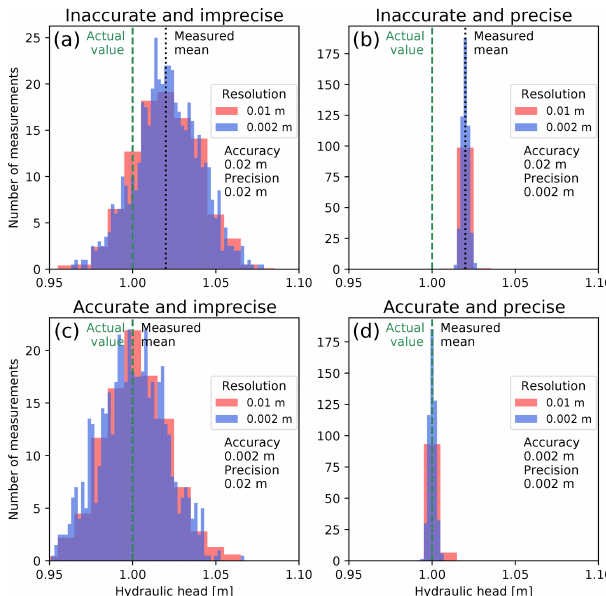
Figure 2. Possible combinations of accuracy, precision and resolu- tion illustrated in a matrix, when 1000 measurements of the same head ( h = 1m) are made. Measurements are (a) inaccurate and im- precise, (b) inaccurate and precise, (c) accurate and imprecise, and (d) accurate and precise. Examples are illustrated with two different values of accuracy, precision and resolutions (equal to bin width in